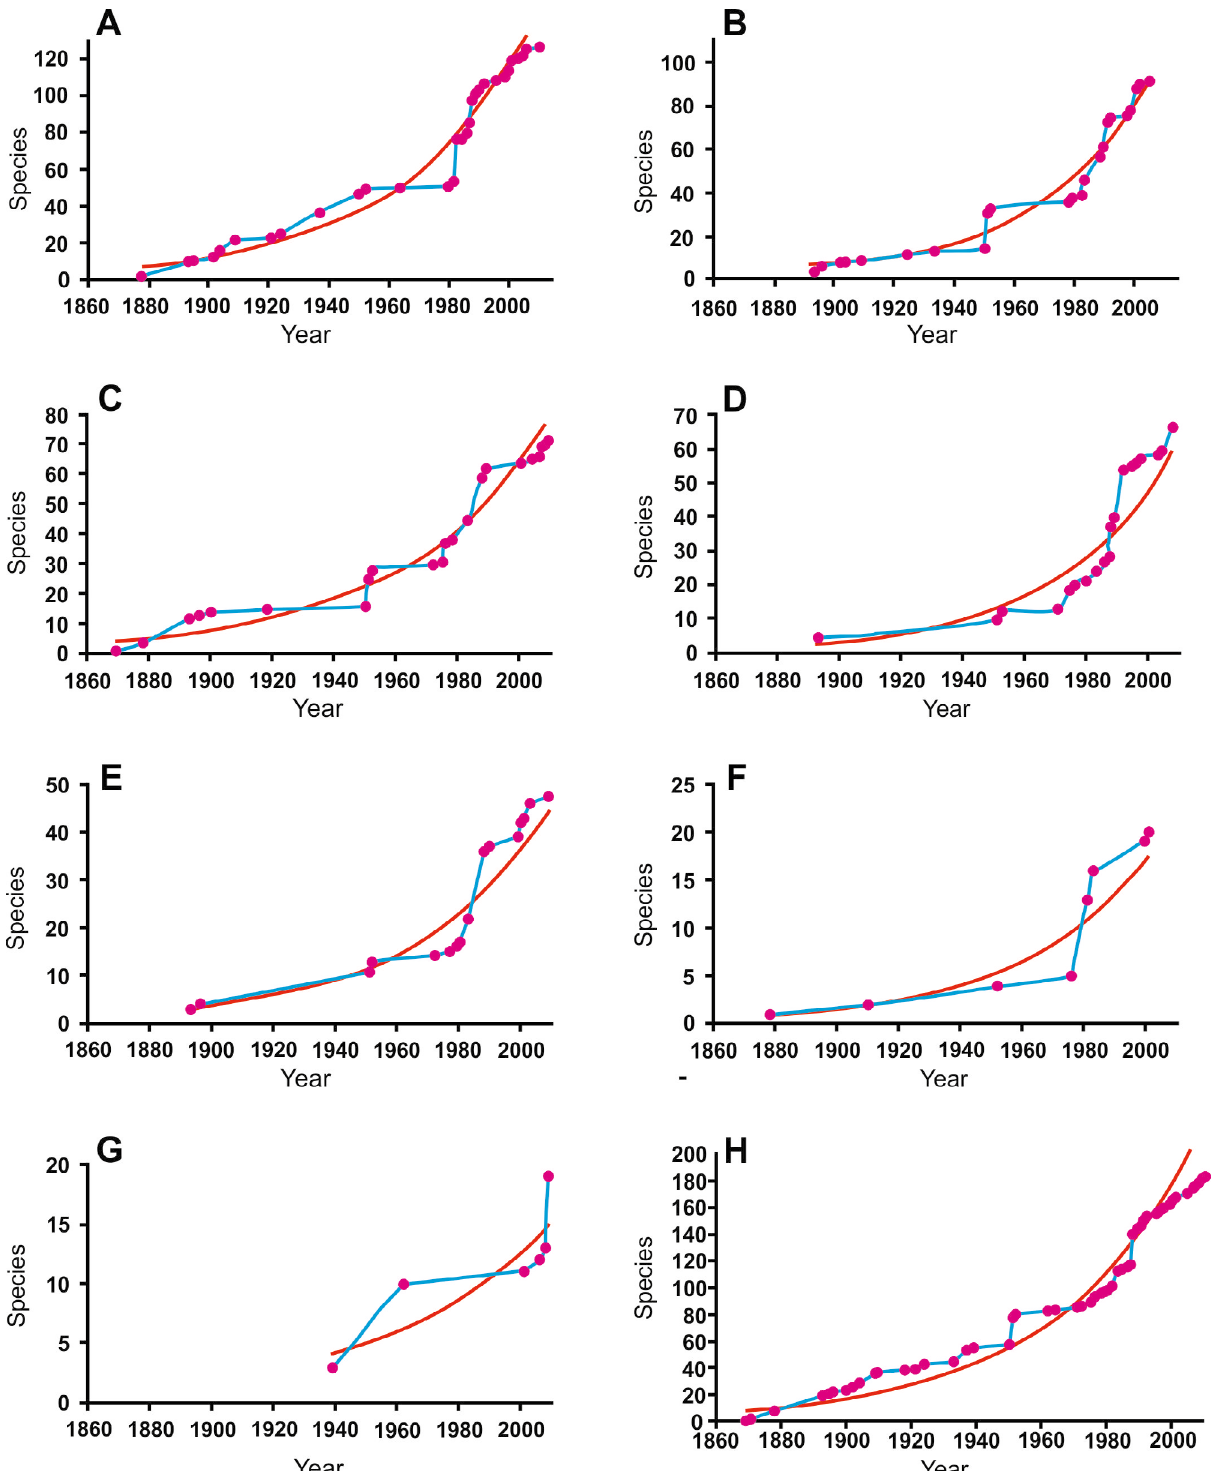
Figure 2. Temporal accumulation species curves of marine benthic caridean shrimps in the Eastern Tropical Pacific. A, Mexico (Mexico-Revillagigedo Archipelago). B, Clipperton Atoll. C, Ecuador (Ecuador-Galapagos Archipelago). D, Costa Rica (Costa Rica- Cocos Island). E, Panama. F, Colombia (Colombia-Malpelo Island). G, Peru. H, Tropical Eastern Pacific. Dotted line= observed values, continuous line= exponential